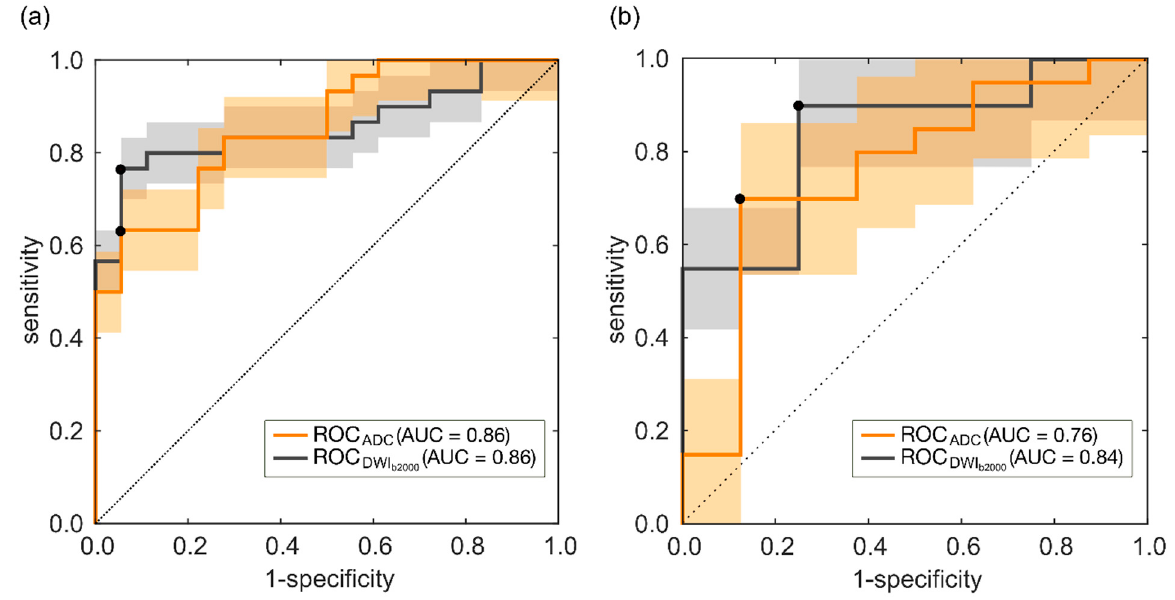
Figure 4. ( a ) ROC curve achieved on the training set for ADC and DWI b2000 models. ( b ) ROC curves achieved on the holdout test set for ADC and DWI b2000 models.